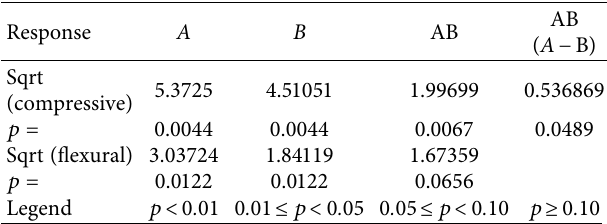
Table 26: Coefficient table.